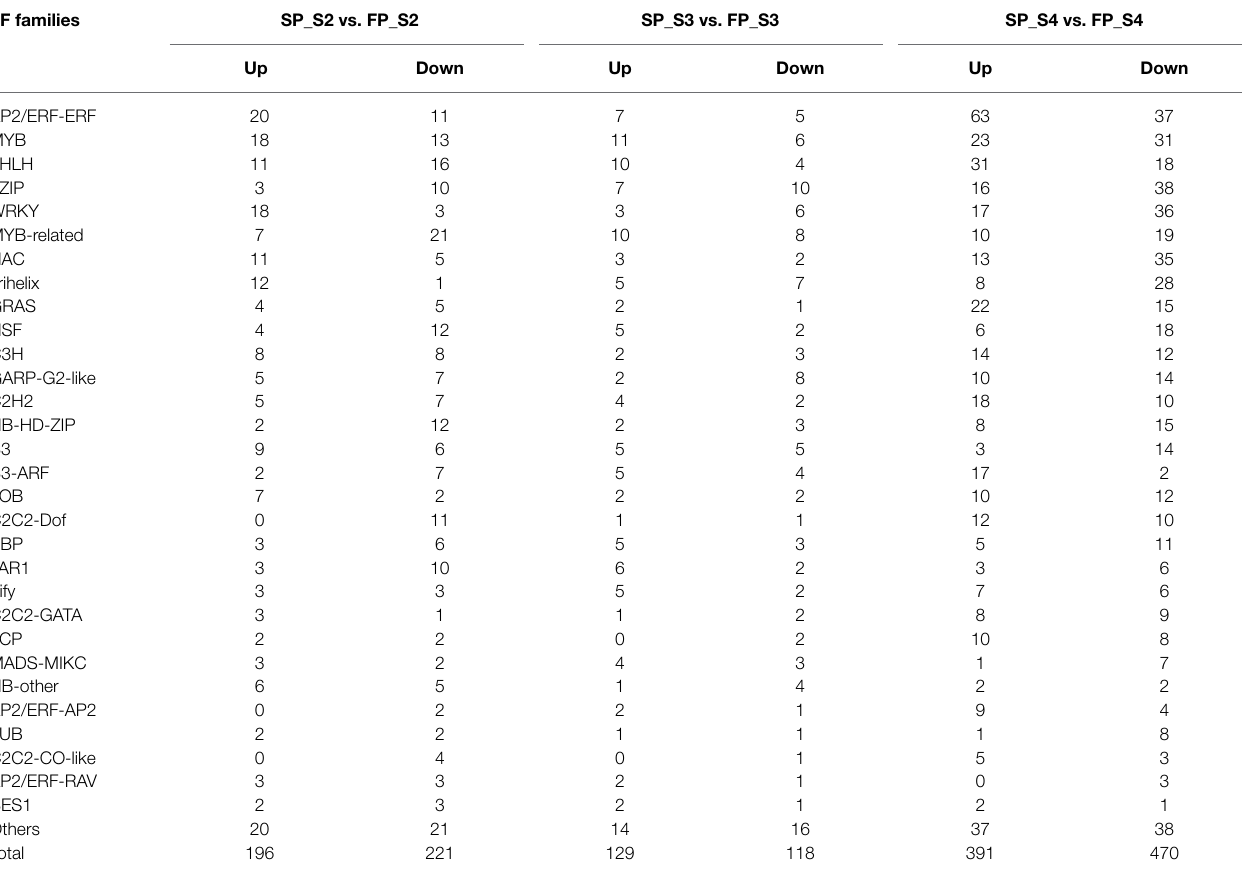
TABLE 2 | Transcription factor families that were greatly respond to continuous cropping. TF